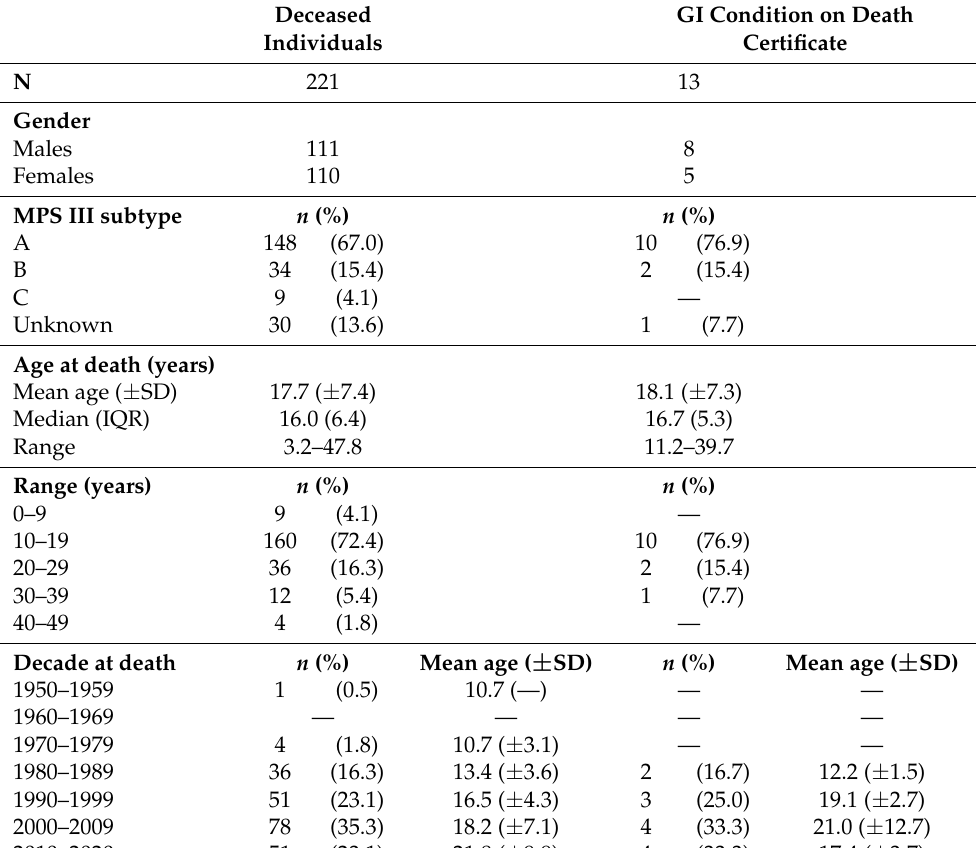
Table 2. Characteristics of deceased individuals with MPSIII on death certificates ( n = 221) and of individuals with GI conditions listed on their death certificate ( n =